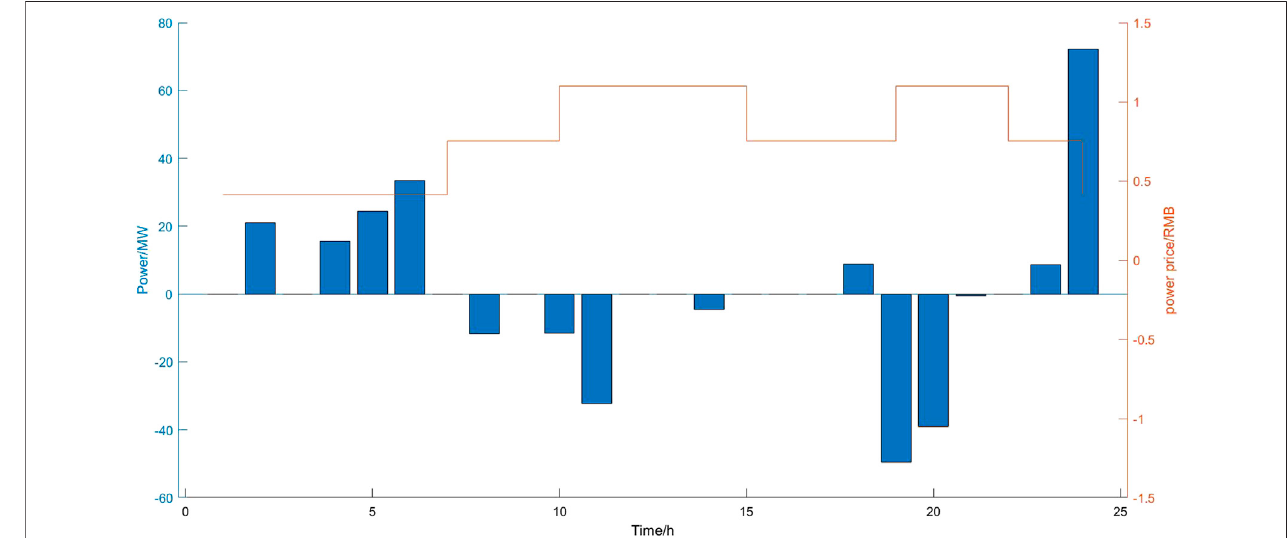
FIGURE 6 | Charging and discharging of storage.